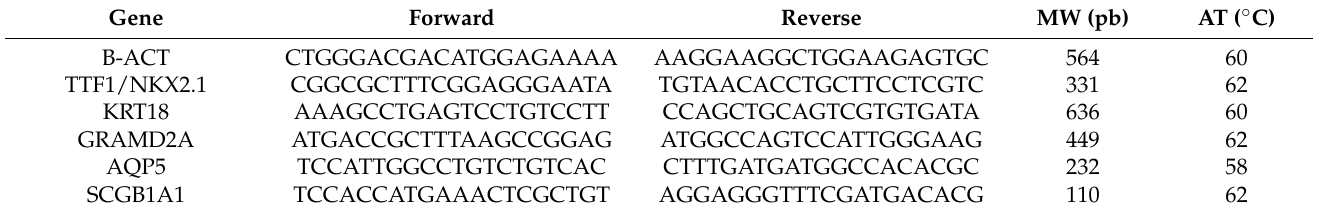
Table 4. Primers for